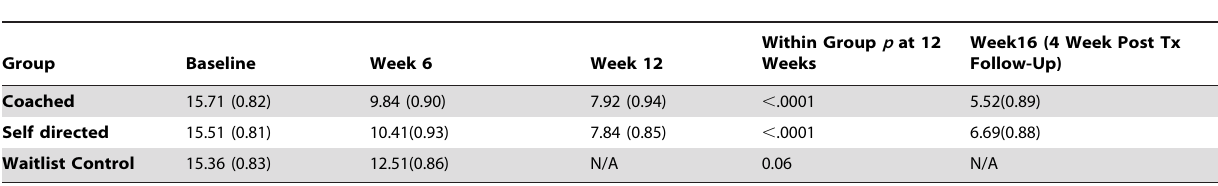
Table 3. Least square means and standard errors for PHQ-9 depression symptom severity